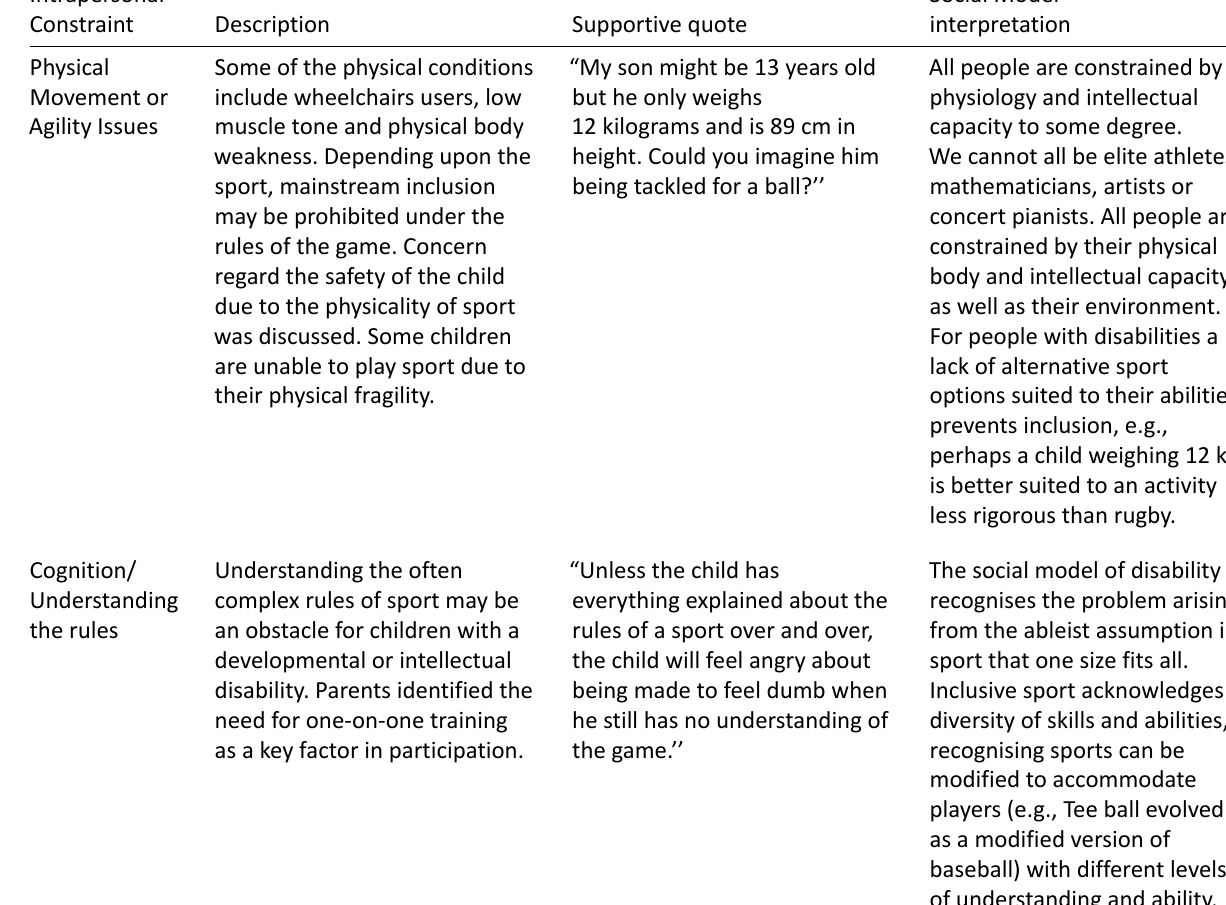
Table 2. Intrapersonal constraints perceived by parents with children with disability (developed from findings).